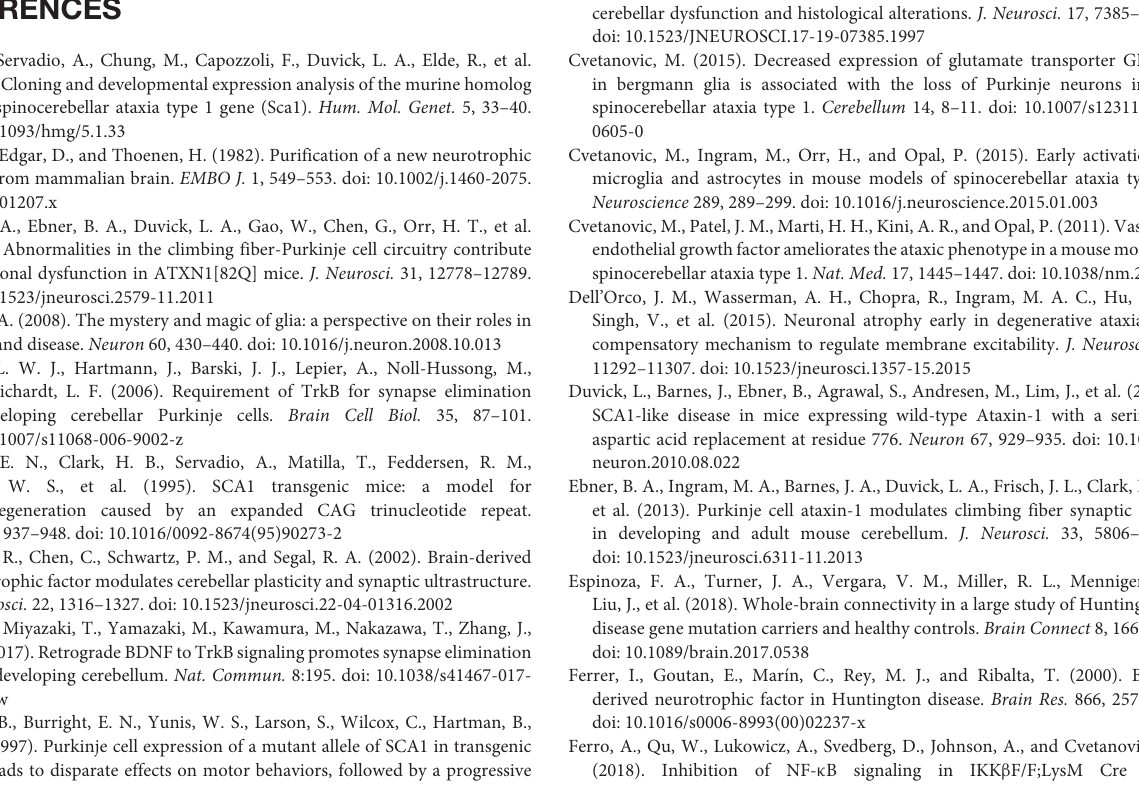
TABLE S1 | BDNF expression from RNA sequencing of mouse cerebellar